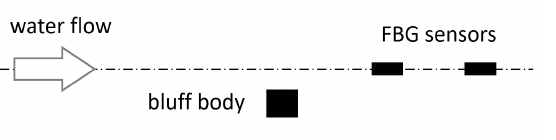
Figure 11. Diagram demonstrating the geometry of an FOS setup described in